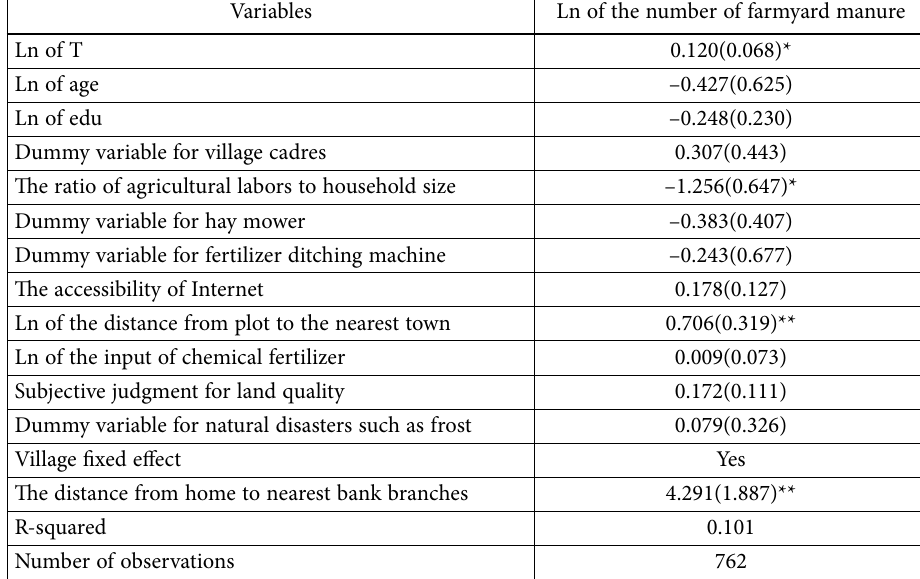
Table 5. The size of farmland transfer and farmland